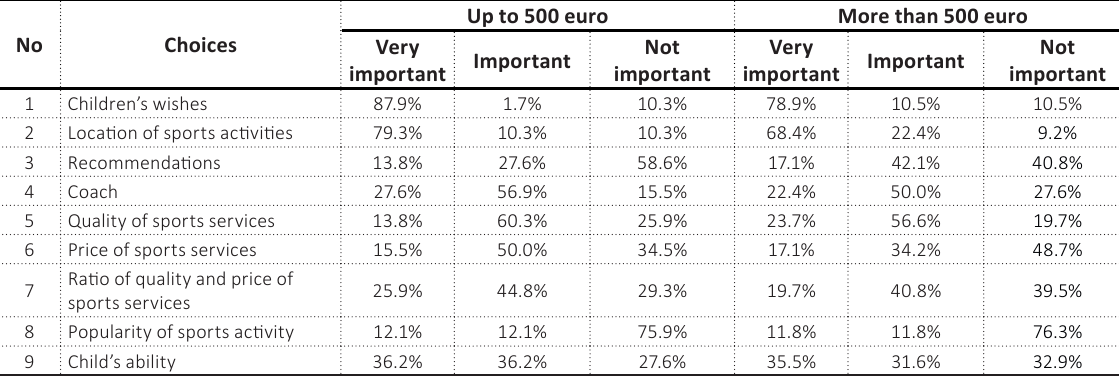
Table 2. Sports club, the sport, or activity selection criteria importance level by two groups of subjects according to household income per family